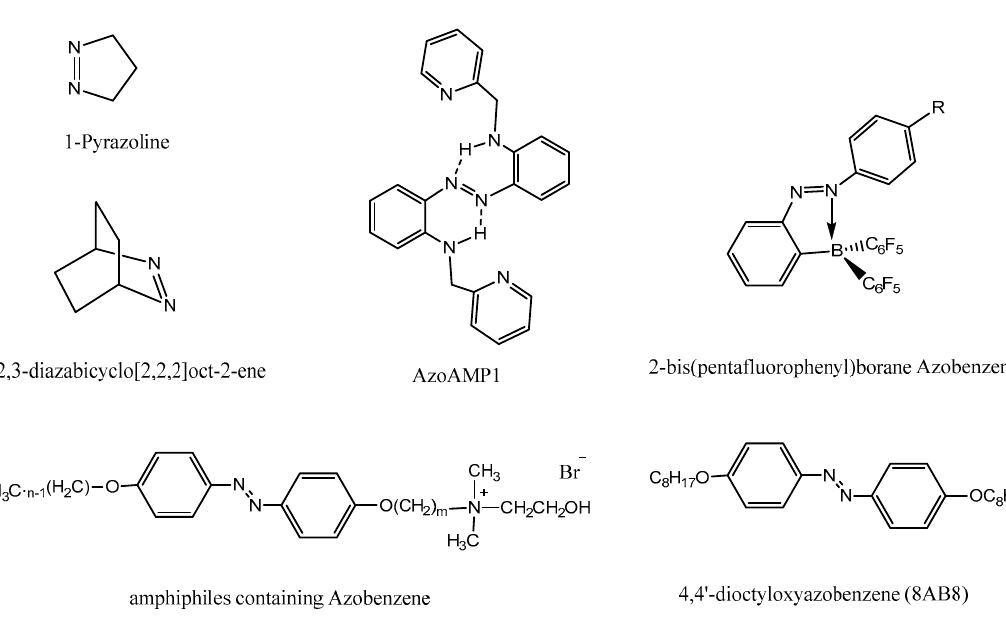
Figure 2. Systems that emit enhanced fluorescence.